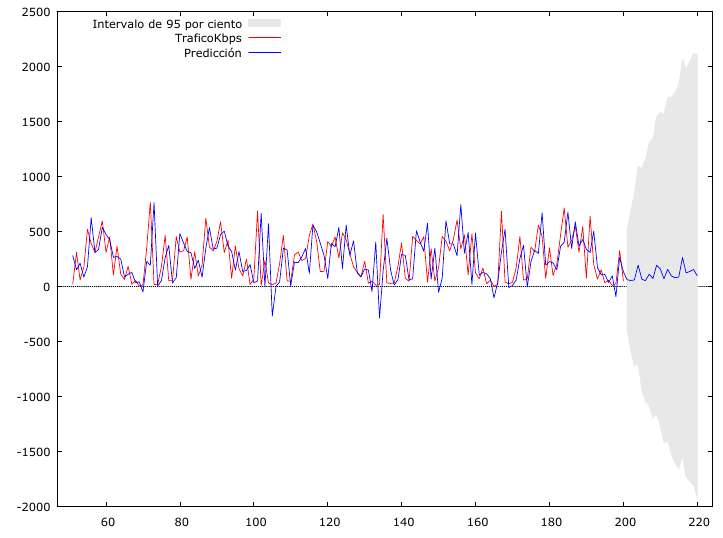
Figure 10. Prediction with 95% adjustment for the SARIMA model (1,1,1) (1,1,2) (32) .